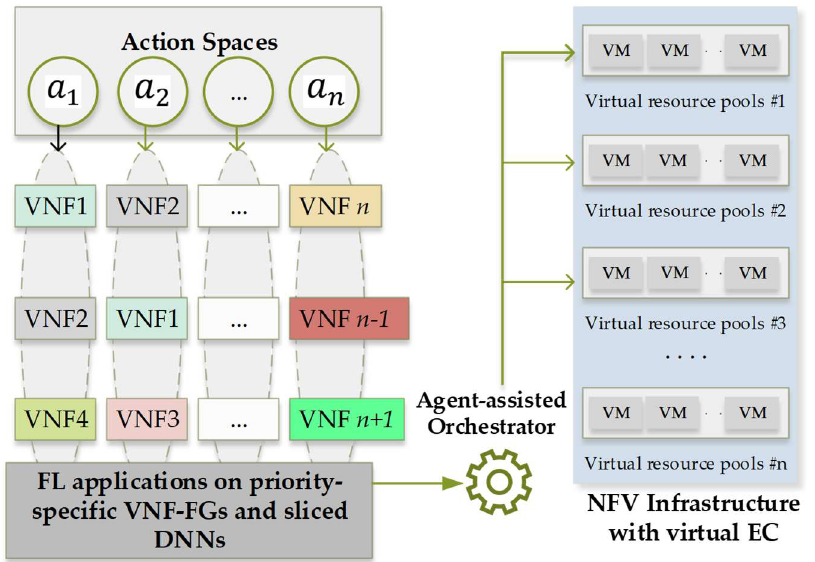
Figure 7. Agent-assisted orchestrator for adaptive action in optimizing FL resources.